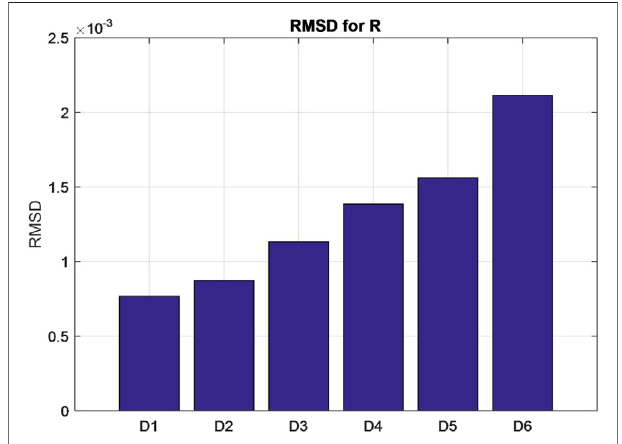
FIGURE 7 | The calculated RMSD-based looseness index under different loosening